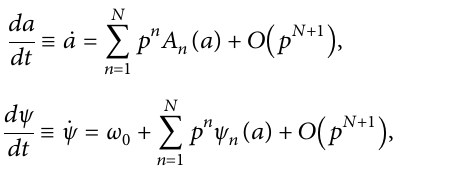
f t to the damped ( ) ⟶